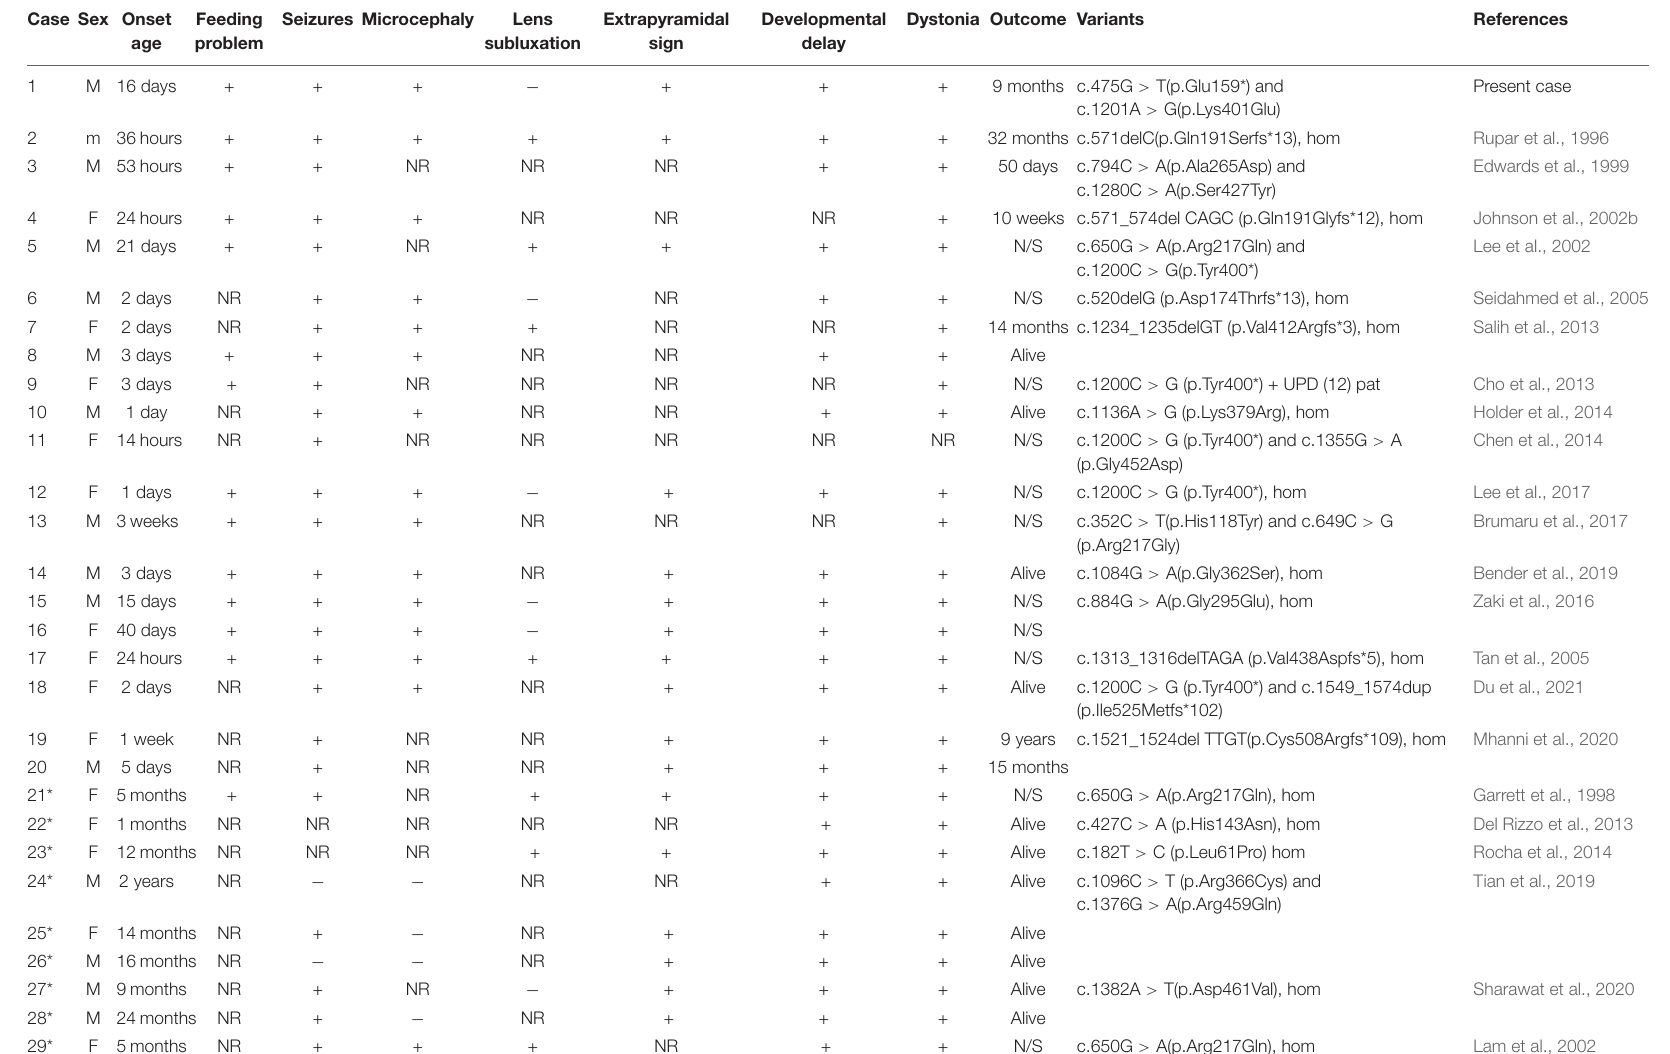
TABLE 1 | Clinical features of the present cases and the reported in the